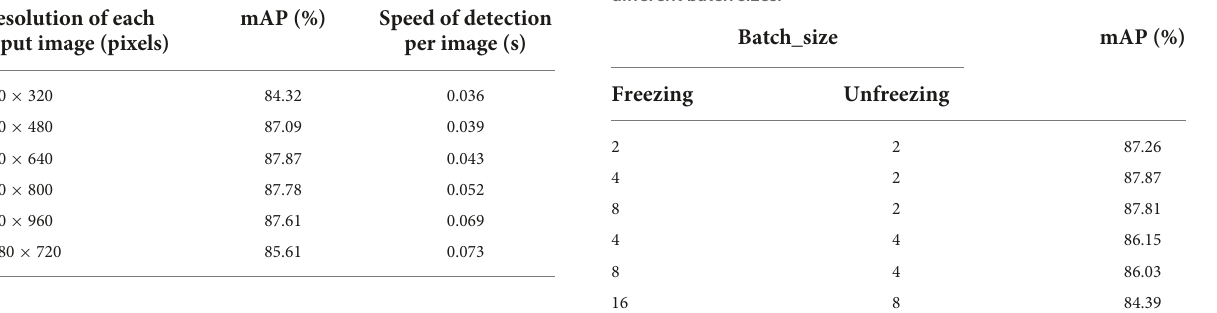
TABLE 2 mAPs and speeds obtained with different input image sizes. TABLE 3 Information regarding the mAPs obtained with different batch